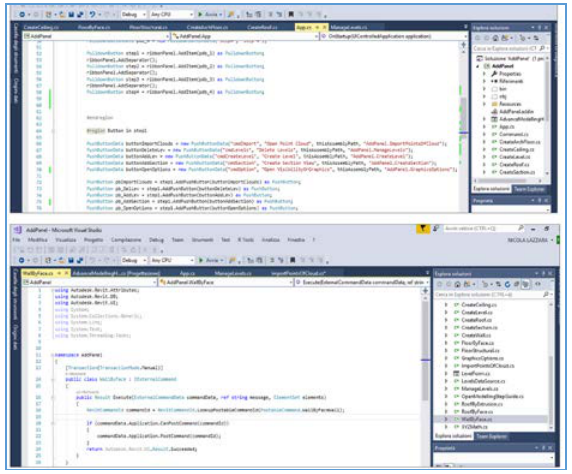
Figure 5. The add-in’s development phases in Visual Studio.